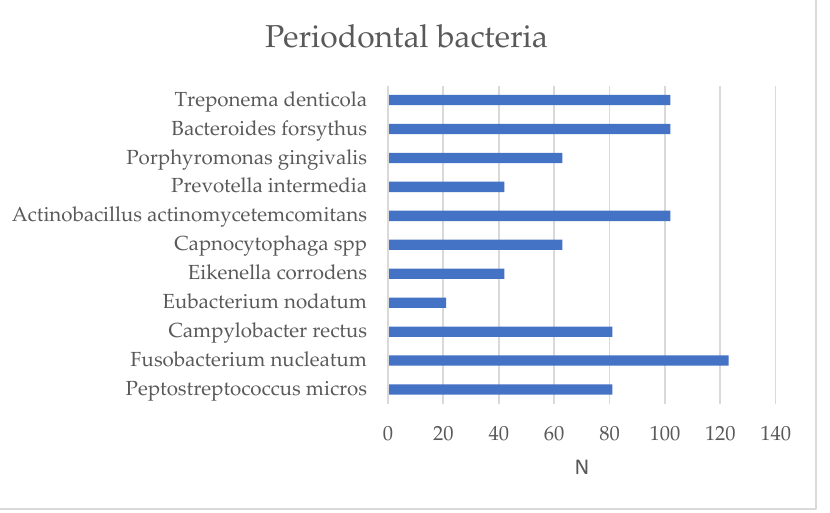
Figure 2. Bacteria present in the gingival crevicular fluid, where N is the number of patients.